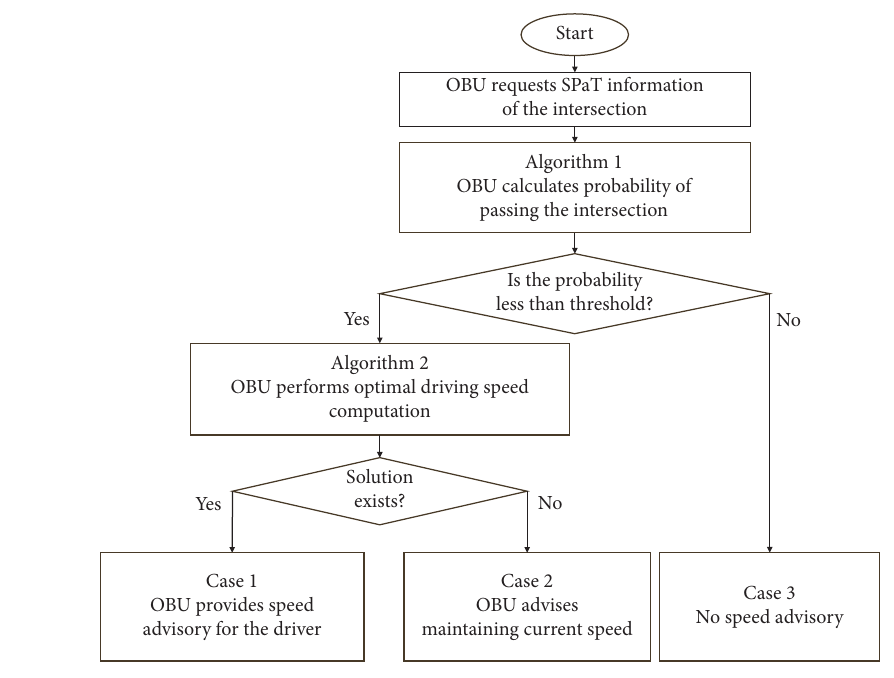
Figure 7: The flowchart of optimal driving speed calculation.